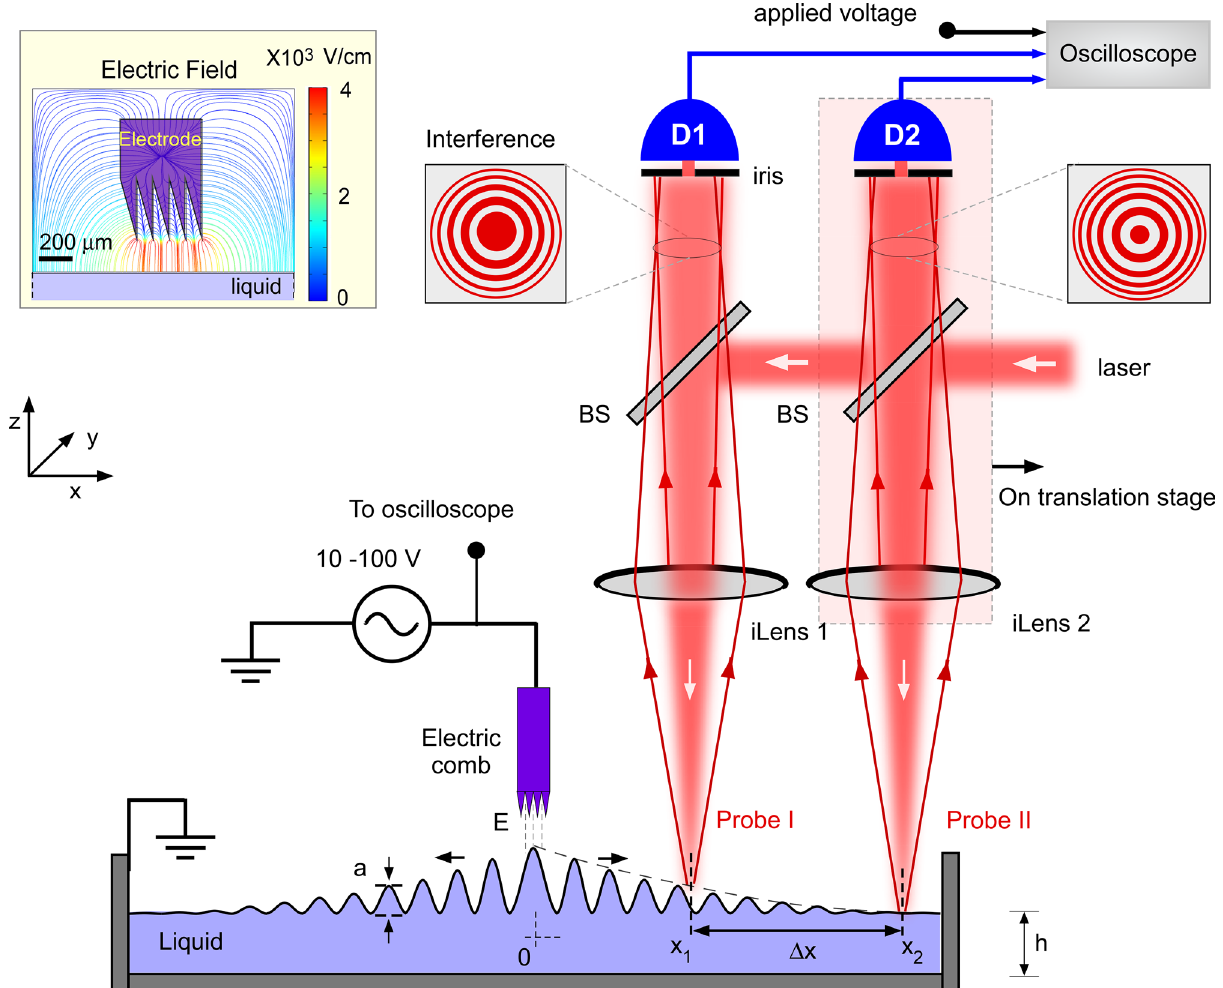
Figure 1. Schematic of experimental setup for viscosity measurement from capillary waves. Capillary waves were generated electrically with multiple sharp edges and their dynamics was resolved by two simple and compact interferometric probes. High-contrast circular interference fringes were obtained by combining the reflections from lenses and liquid surface. Photo-diodes (D1 and D2) record central fringe intensity in oscilloscope. iLens1,2: single-lens interferometers, BS: Beam splitter. Inset presents the simulated electric field of the electrode at 50 V. The schematic drawing is created in Canvas X, Version: X Built 925. https:// www. canva sgfx.